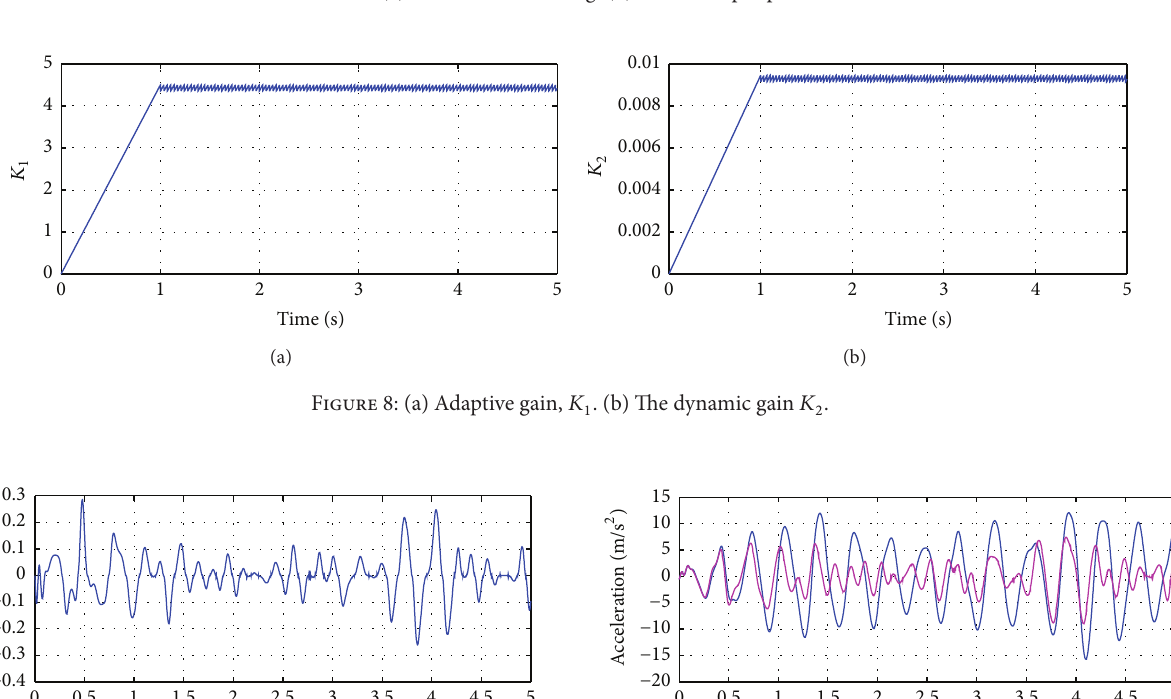
Figure 7: (a) Effective tire loading. (b) Control input provided.